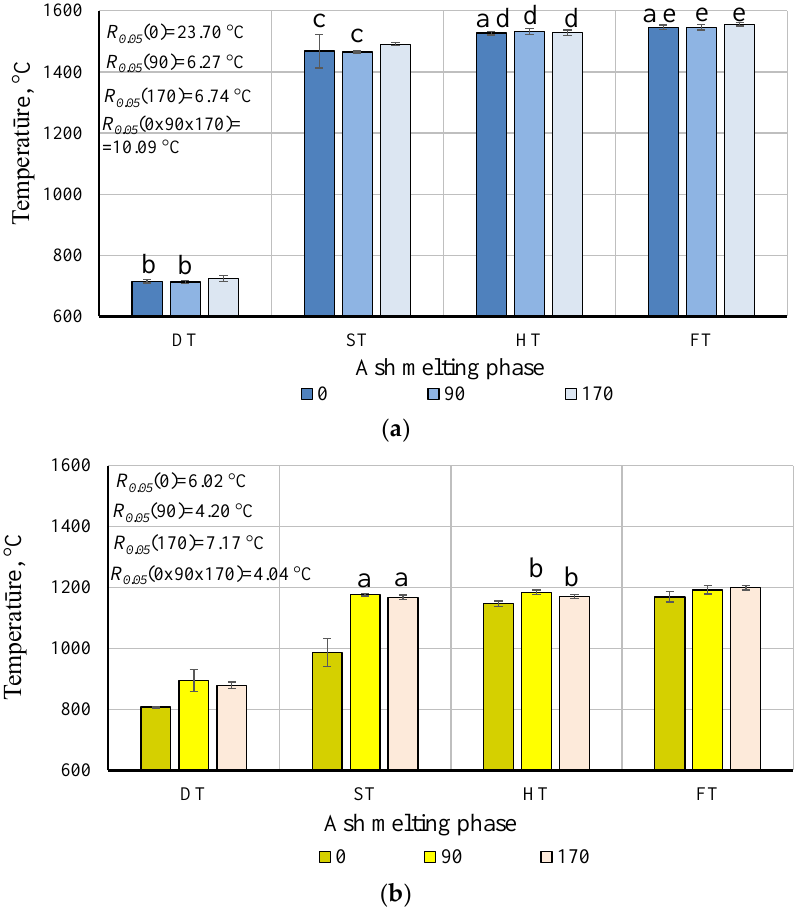
Figure 6. Ash melting temperature of Artemisia dubia Wall. ( a ), Miscanthus×giganteus ( b ) when they were not fertilized, fertilized with mineral nitrogen fertilizers 90 and 170 kg ha −1 : DT, deformation temperature; ST softening temperature; HT, hemispherical temperature; FT, flow temperature; a, b, c, d, e, there are no statistically significant differences ( p < 0.05) between the columns marked with the same letter, as assessed using the least significant difference.